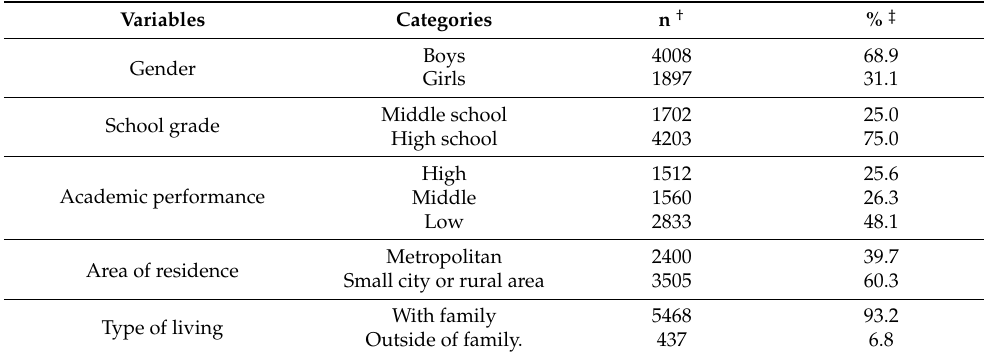
Table 1. General characteristics of participants (N =